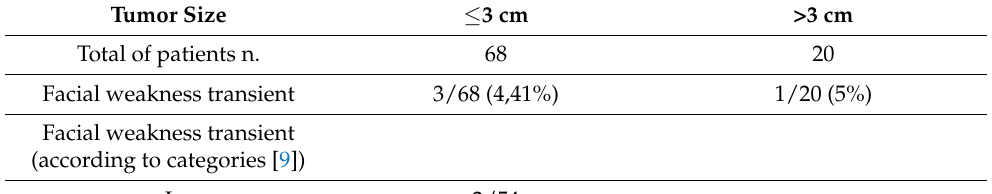
Table 3. Complications according to size and categories (Categories according to Quer et al. [9]).